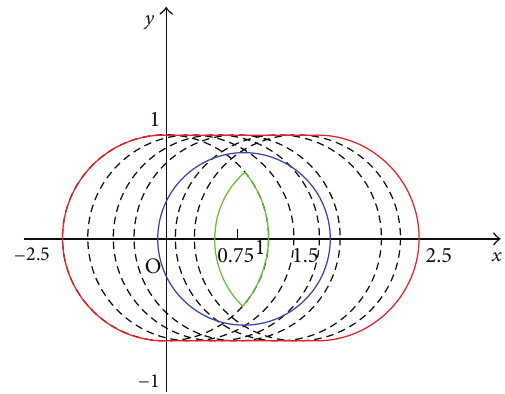
Figure 2: Random set approximated using the rough